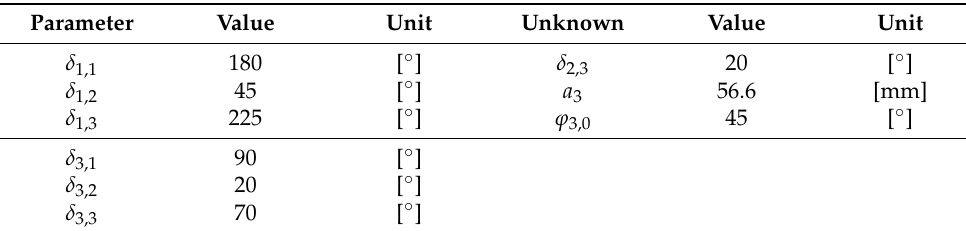
Table 2. Numerical values used in the synthesis of the mechanism. Design requirements to the left, fixed unknown values to the